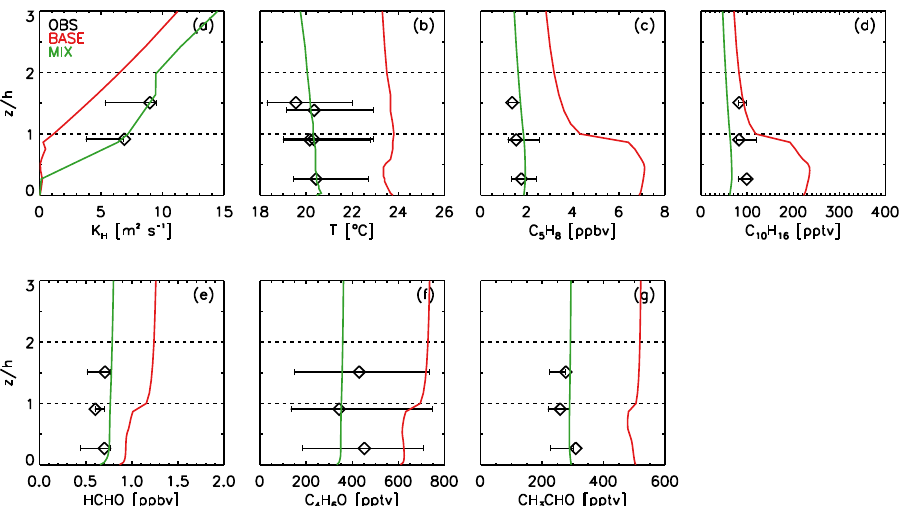
Fig. 4. Measured and modeled vertical profiles of (a) eddy diffusivity, (b) temperature, (c) isoprene, (d) monoterpenes, (e) formaldehyde, (f) MACR+MVK, and (g) acetaldehyde at 14 EST 5 August 2009. Whiskers denote the standard deviations for the sunny and partly sunny days (21, 29 July, 2, 4, 5, and 7